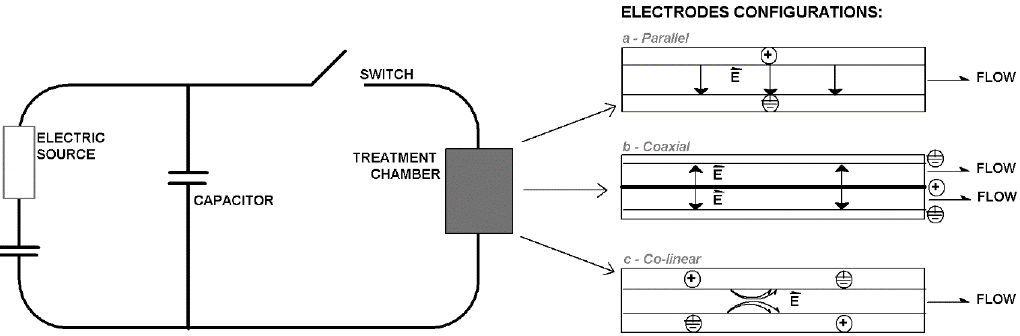
Figure 1. Schematic representation of a pulsed electric fields (PEF) circuit system for producing exponentially decay pulses, including the structure of the most exploited treatment chambers.